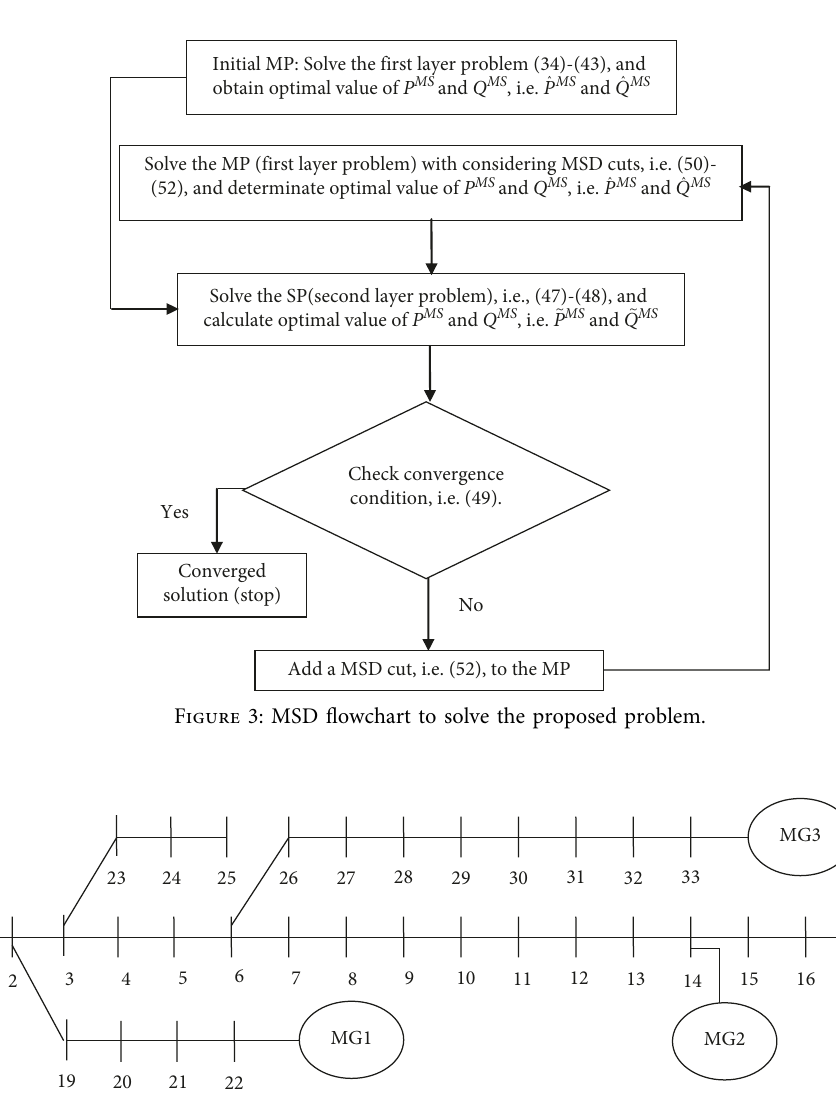
Figure 4: The scheme of the 33-bus distribution network including MMG [58].